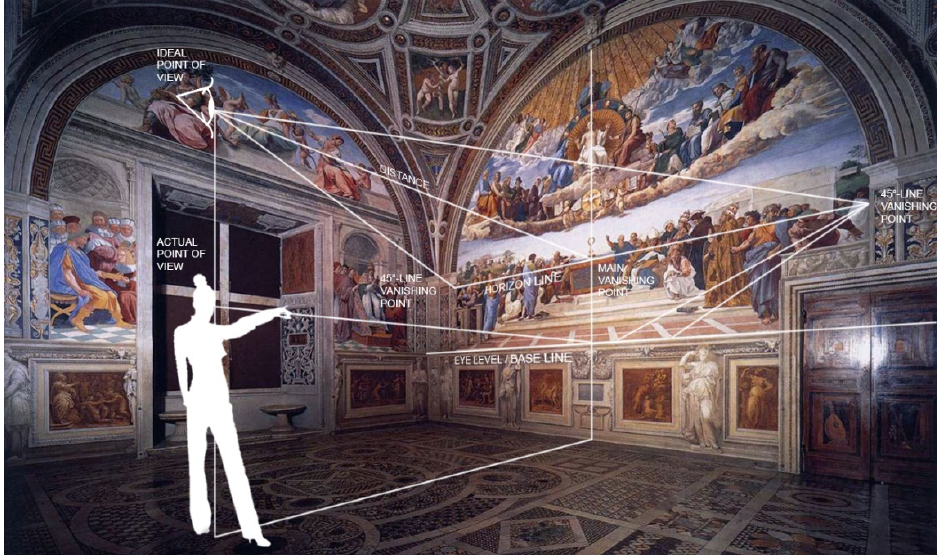
Figure 14. General perspective structure of Raffaello’s The Disputa and the beholder in front of it. The three levels of figures in The Dispute appear to be hinged on the vertical axis of the monstrance upon the altar. The perspective analysis individuated the central vanishing point at the base of the monstrance itself, where the horizon line passes. Both “earthly” and “celestial” painted elements are ruled by this vanishing point.